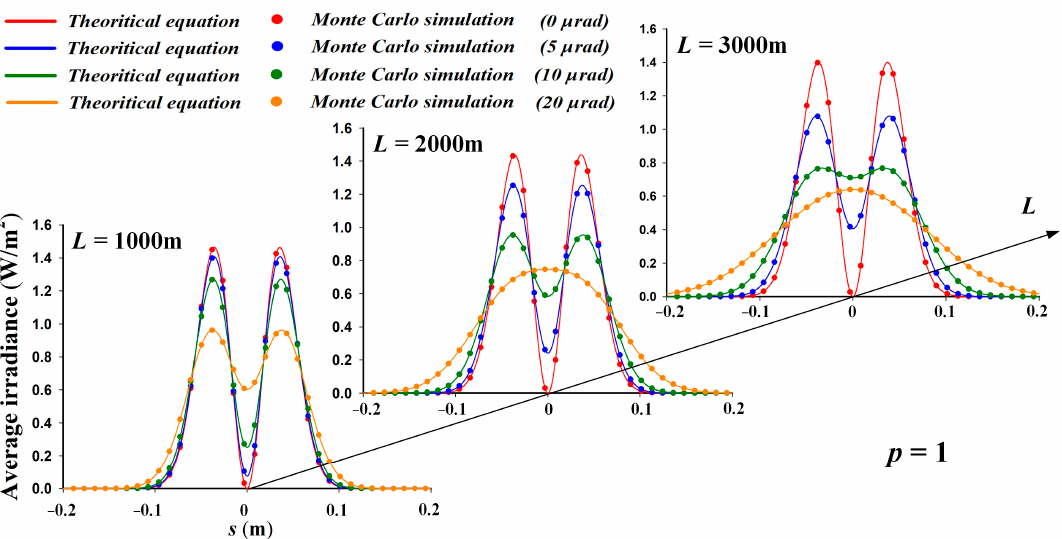
Figure 2. Average irradiance of HG beam under pointing error with the increase in propagation distance in the case of p = 1 .